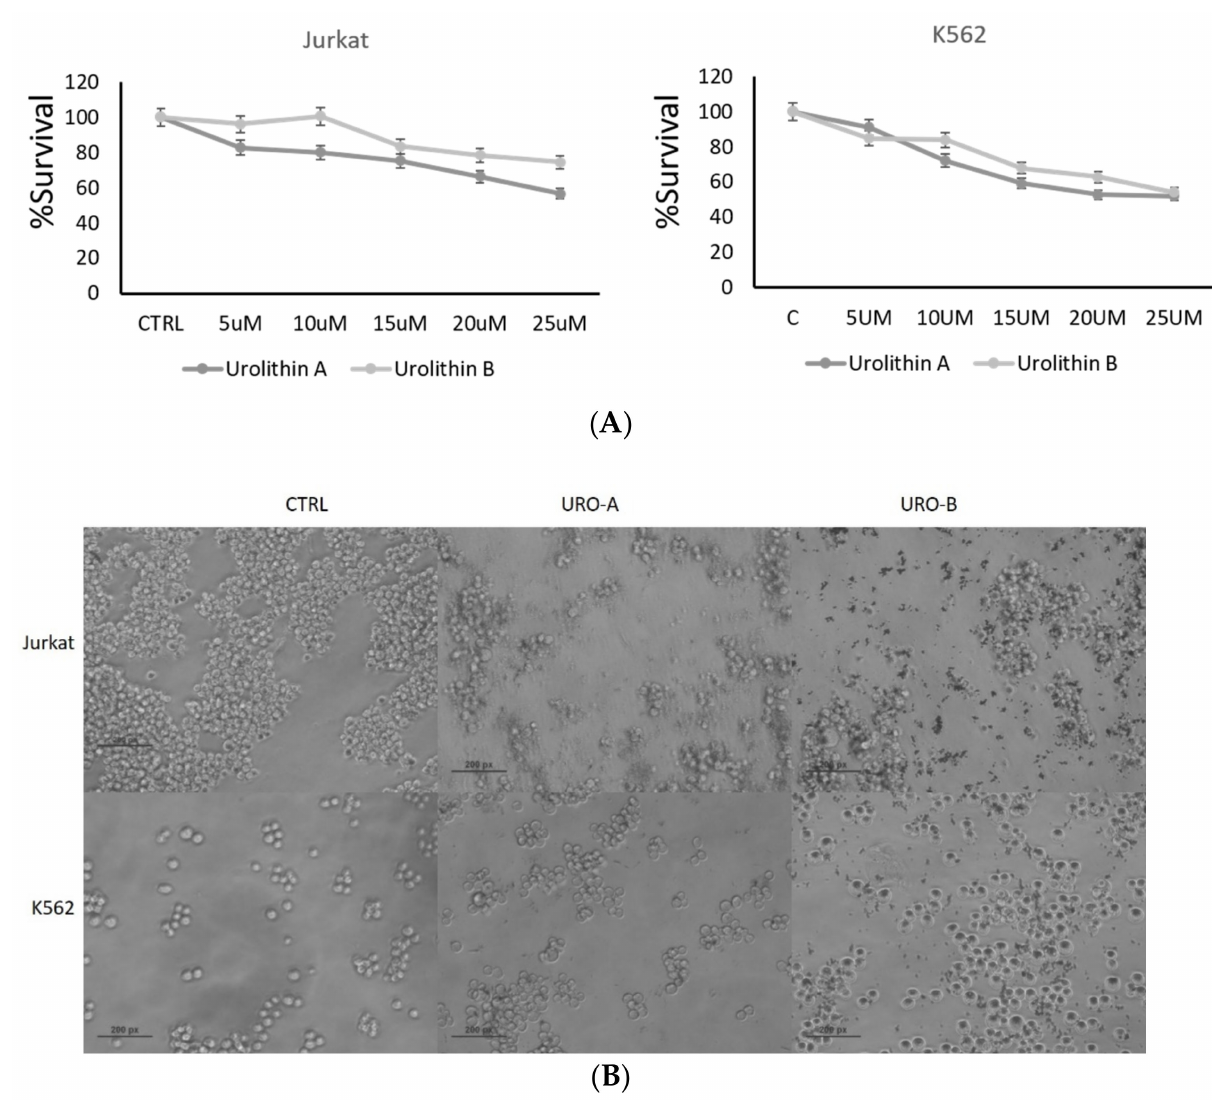
Figure 1. Urolithin A and B treatments reduce cell proliferation and alter cellular morphology ( A , B ). MTT assays were performed to determine cell viability upon treating with different concentrations of urolithin A and B for 48 h in both Jurkat and K562. All the images are captured by using a Nikon phase contrast microscope at 20 × . p <